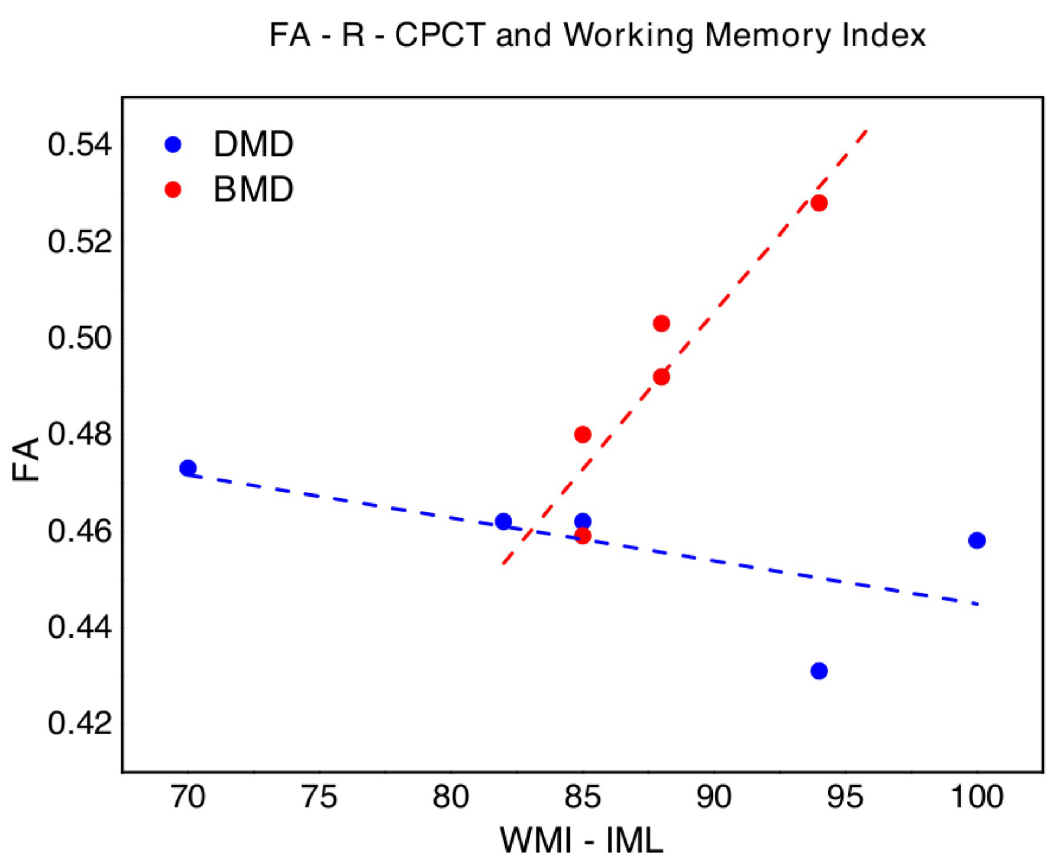
Fig 4. FA of the right corticopontocerebellar tract (FA-R-CPCT) values versus Working Memory Index (WMI, WISC-IV) in DMD (blue points) and BMD (red points). The dotted lines (blue for DMD and red for BMD respectively) represent the linear fit of the data with a function y = a + b � x. DMD: a = 0.53 ± 0.05, b = -0.001 ± 0.0005, Pearson’s R = -0.66, Adj R 2 = 0.24; BMD: -0.08 ± 0.13, b = 0.007 ± 0.0001, Pearson’s R = 0.93, Adj R 2 =